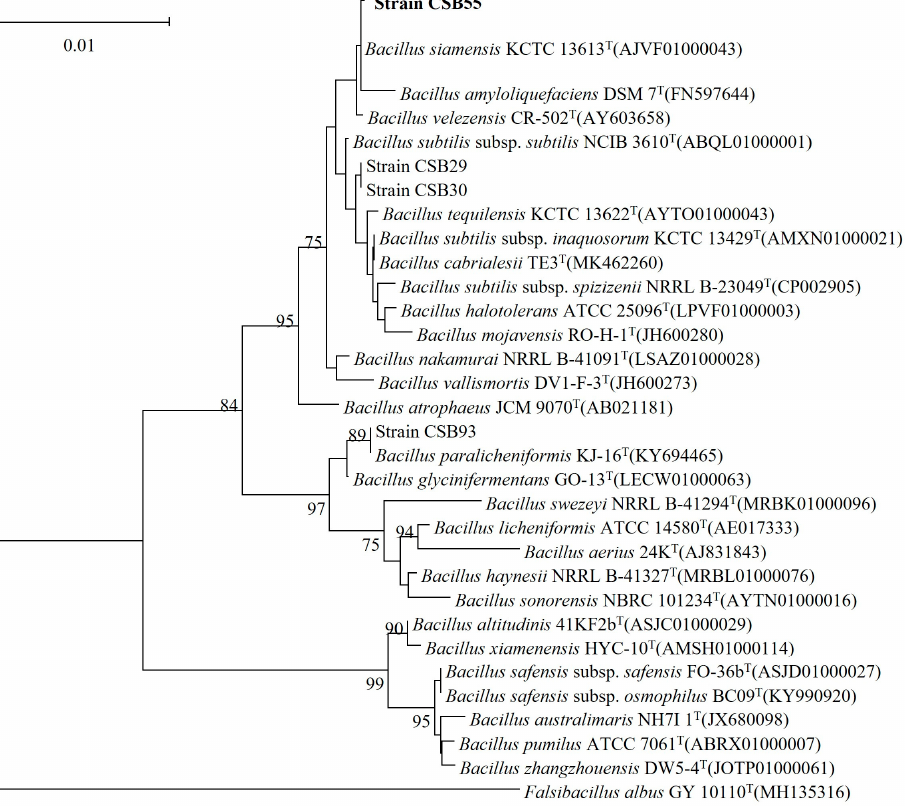
Figure 1. Neighbor-joining phylogenetic tree reconstructed based on 16s rRNA gene sequences displaying relationships between CSB55 and several nearly related taxa of the genus Bacillus.